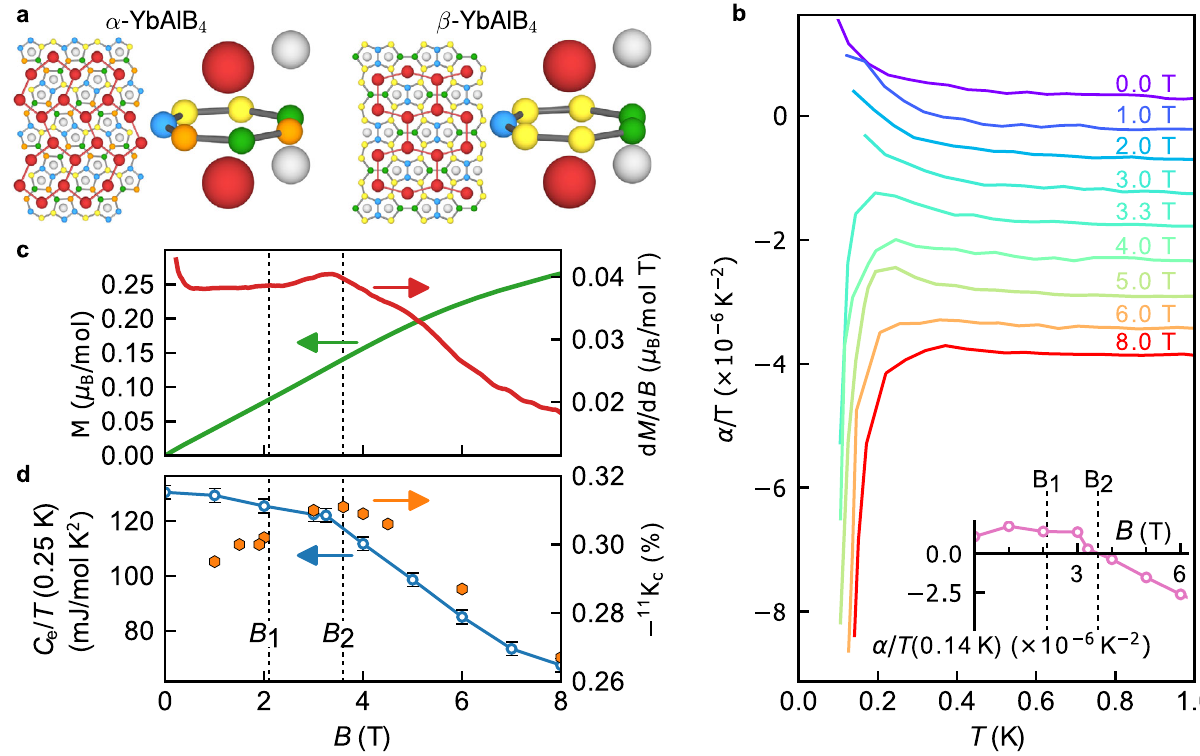
Fig. 1 Crystal structure and magnetic fi eld B ∥ c axis behavior. a Crystal structure of YbAlB 4 formed from straight and zigzag arrangements of hexagons of Yb atoms, and the atomic neighborhood of Yb ions — the Yb site is shown in red together with the surrounding B and Al sites. B sites are colored in blue, yellow, green and orange according to their symmetry position, while Al is gray. b Thermal expansion Δ L c / L c and thermal expansion coef fi cient (cid:1) (cid:3) α ¼ d Δ L = L = dT along the c axis for several magnetic fi elds. The inset shows the fi eld dependence of α c taken at 140 mK. c Magnetization and c c c susceptibility χ = dM / dB vs B ∥ c at T = 0.08 K. d Electronic speci fi c heat coef fi cient γ e measured at 250 mK and Knight shift of the 11 B nucleus vs B ∥ c measured at 142 mK. Vertical error bars in fi gure are least-square fi t errors (1